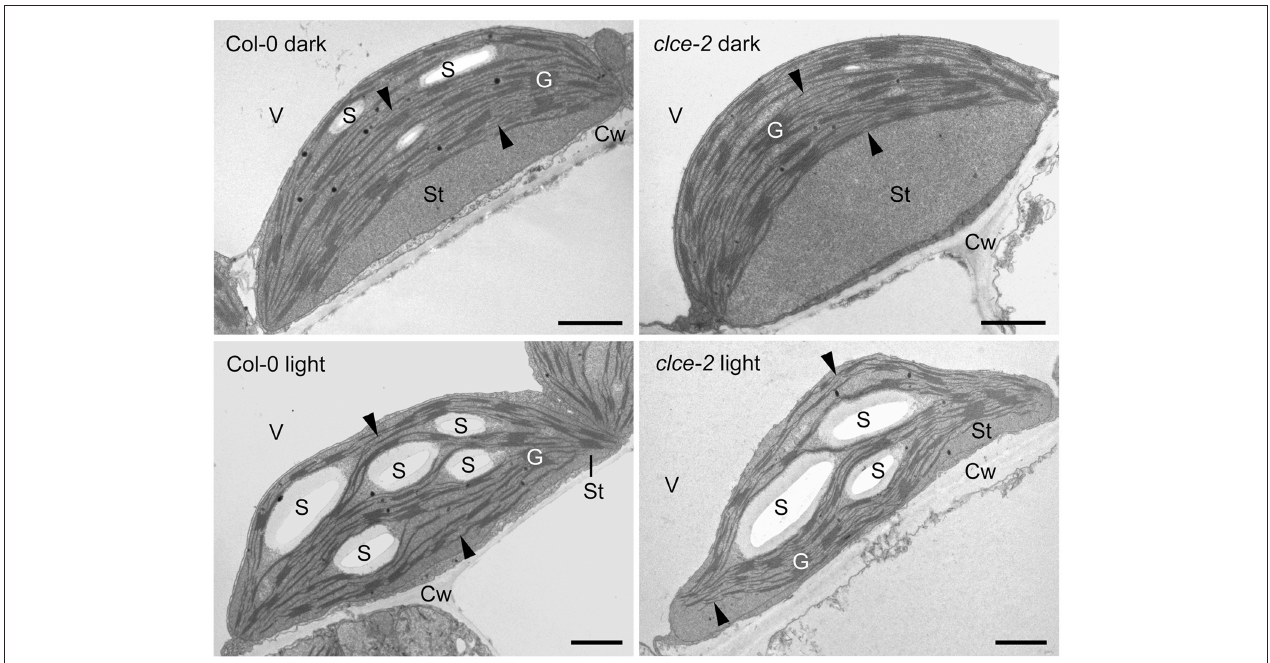
FIGURE 10 | Representative transmission electron micrographs of chloroplasts. Leaves from 7-week-old wild-type and mutant plants that were dark-adapted for 16h (“dark”) or further illuminated for 3h at 120 µ mol photons m − 2 s − 1 (“light”) were fixed in dim green light for electron microscopy. Arrowhead, stroma thylakoids; Cw, cell wall; G, granum; S, starch; St, chloroplast stroma; V, vacuole. Scale bar: 1 µ